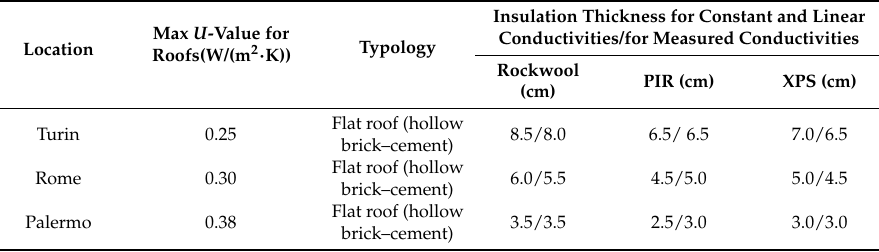
Table 2. Maximum U -value data prescribed in Italy used for the selection of the building systems and insulation thickness for constant, linear, and measured conductivities—horizontal